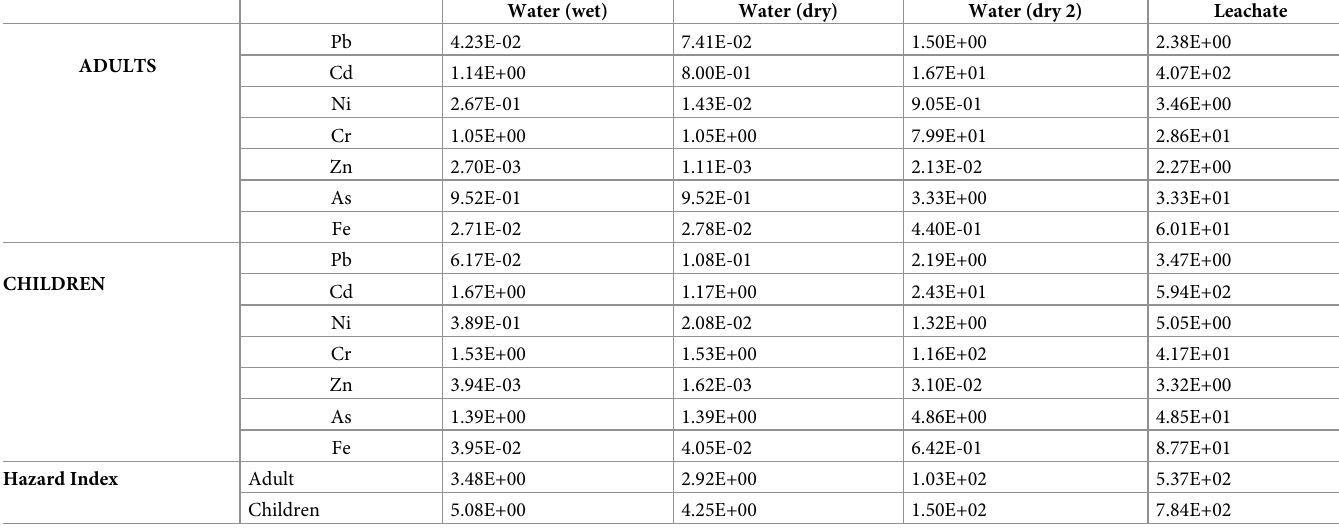
Table 9. Hazard quotient associated with heavy metal exposure in adults and